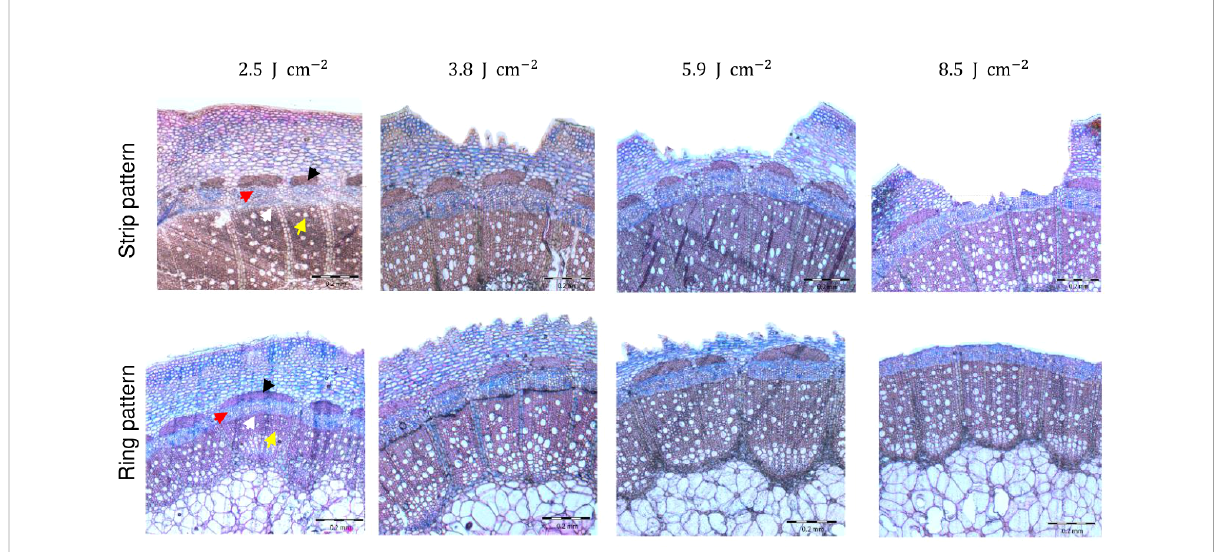
FIGURE 3 Histological analysis of laser wounding applied as strip and ring pattern on Rosa ‘ Tan09283 ’ cuttings under four different energy densities (2.5 J cm -2 , 3.8 J cm -2 , 5.9 J cm -2 and 8.5 J cm -2 ). Arrows indicate sclerenchyma (black), phloem (red), vascular cambium (white) and xylem